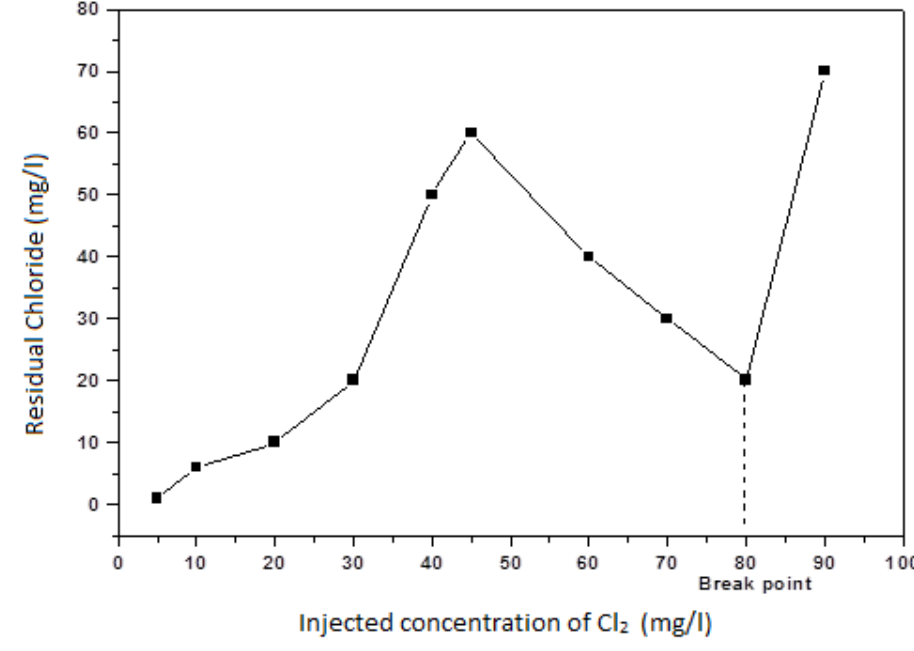
Figure 2. Disinfection break point determining curve of treated wastewater.